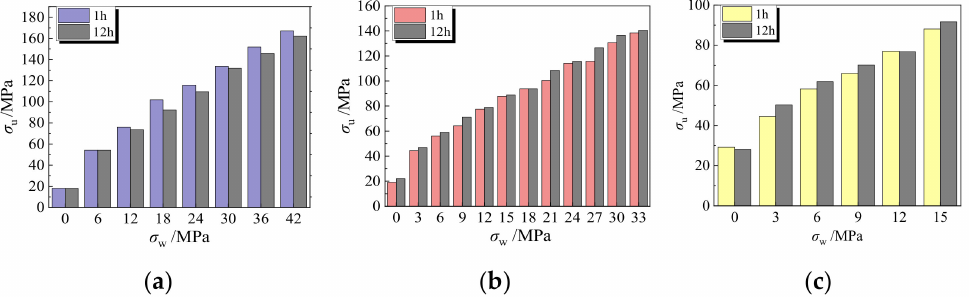
Figure 9. The influence of soaking time under the same confining pressure. ( a ) LAC20, ( b ) LAC30, ( c )